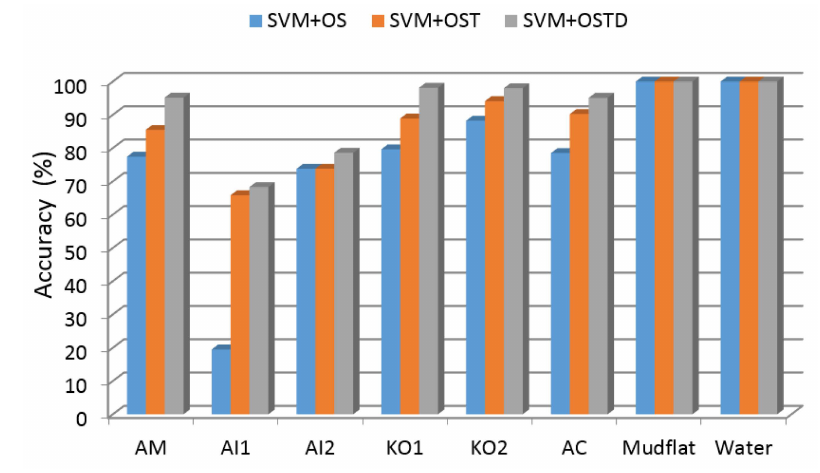
Figure 6. Producer’s accuracy.